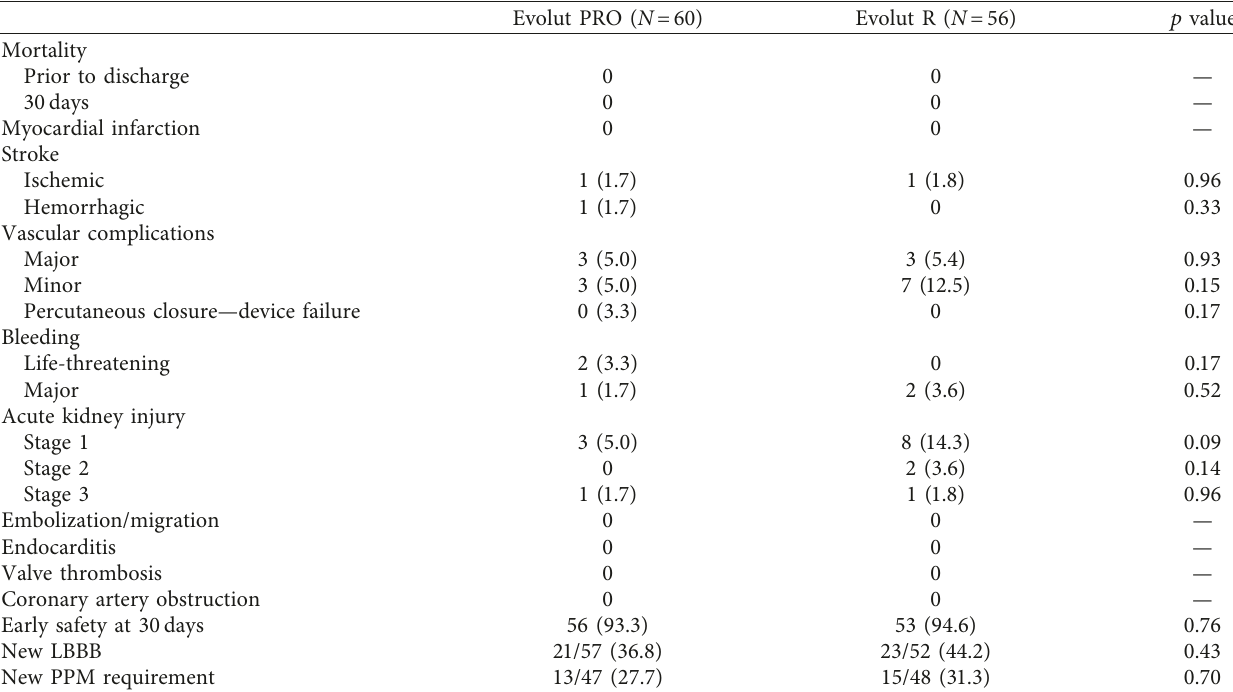
Table 5: Clinical outcomes and safety endpoints.